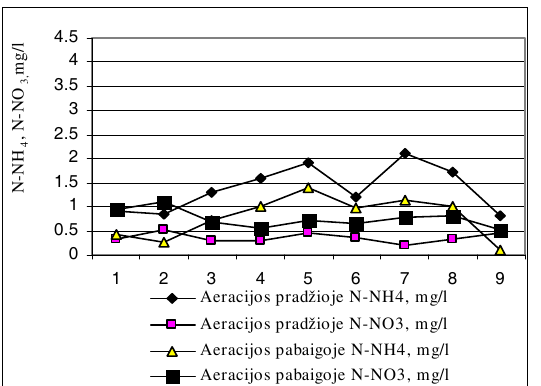
Fig 5. Concentration change of ammonium nitrogen and nitrates in the first aeration tank in the beginning and at the end of aeration at aeration rate of 180 min, and redu- ced aeration rate of 150 min